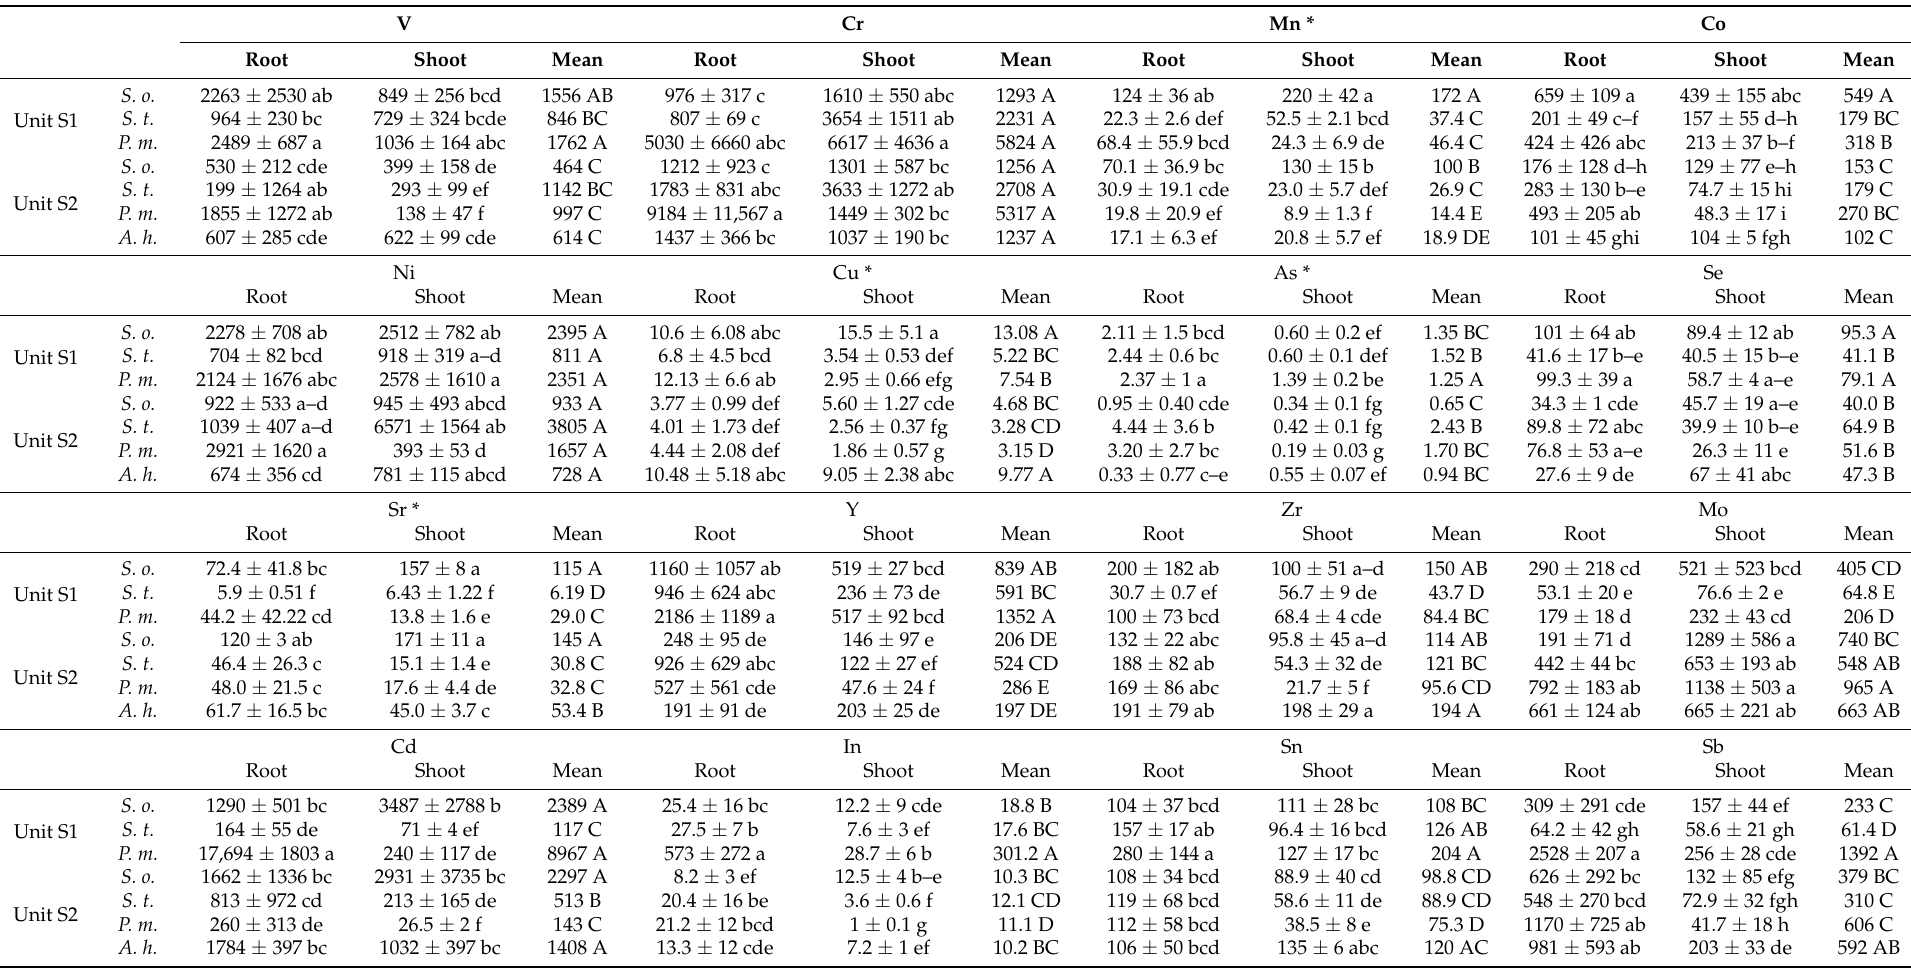
Table 5. Metal(loid)s and REEs concentration in different